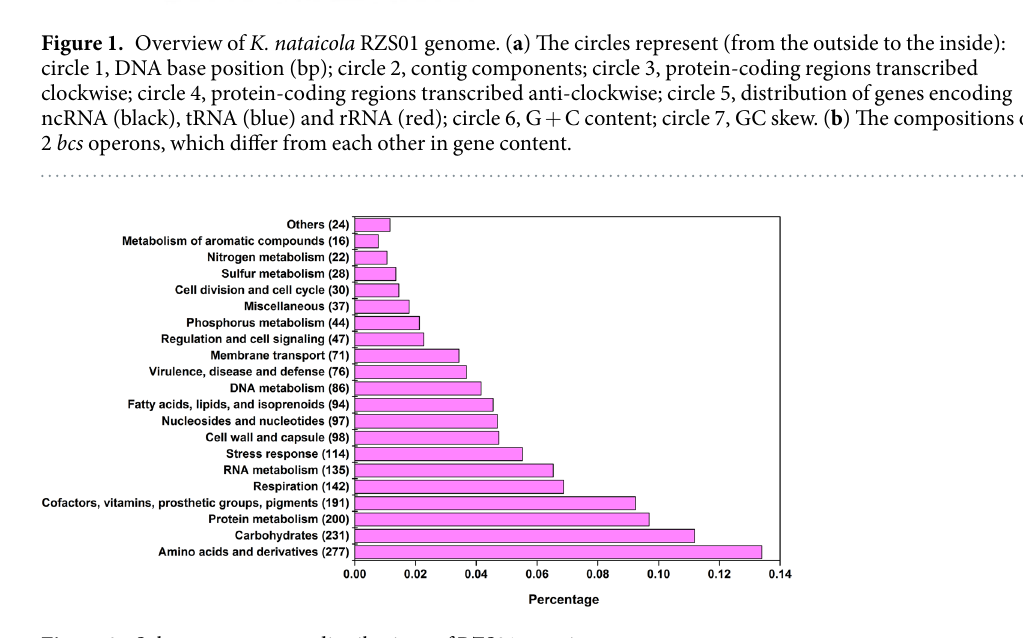
Figure 2. Subsystem category distributions of RZS01